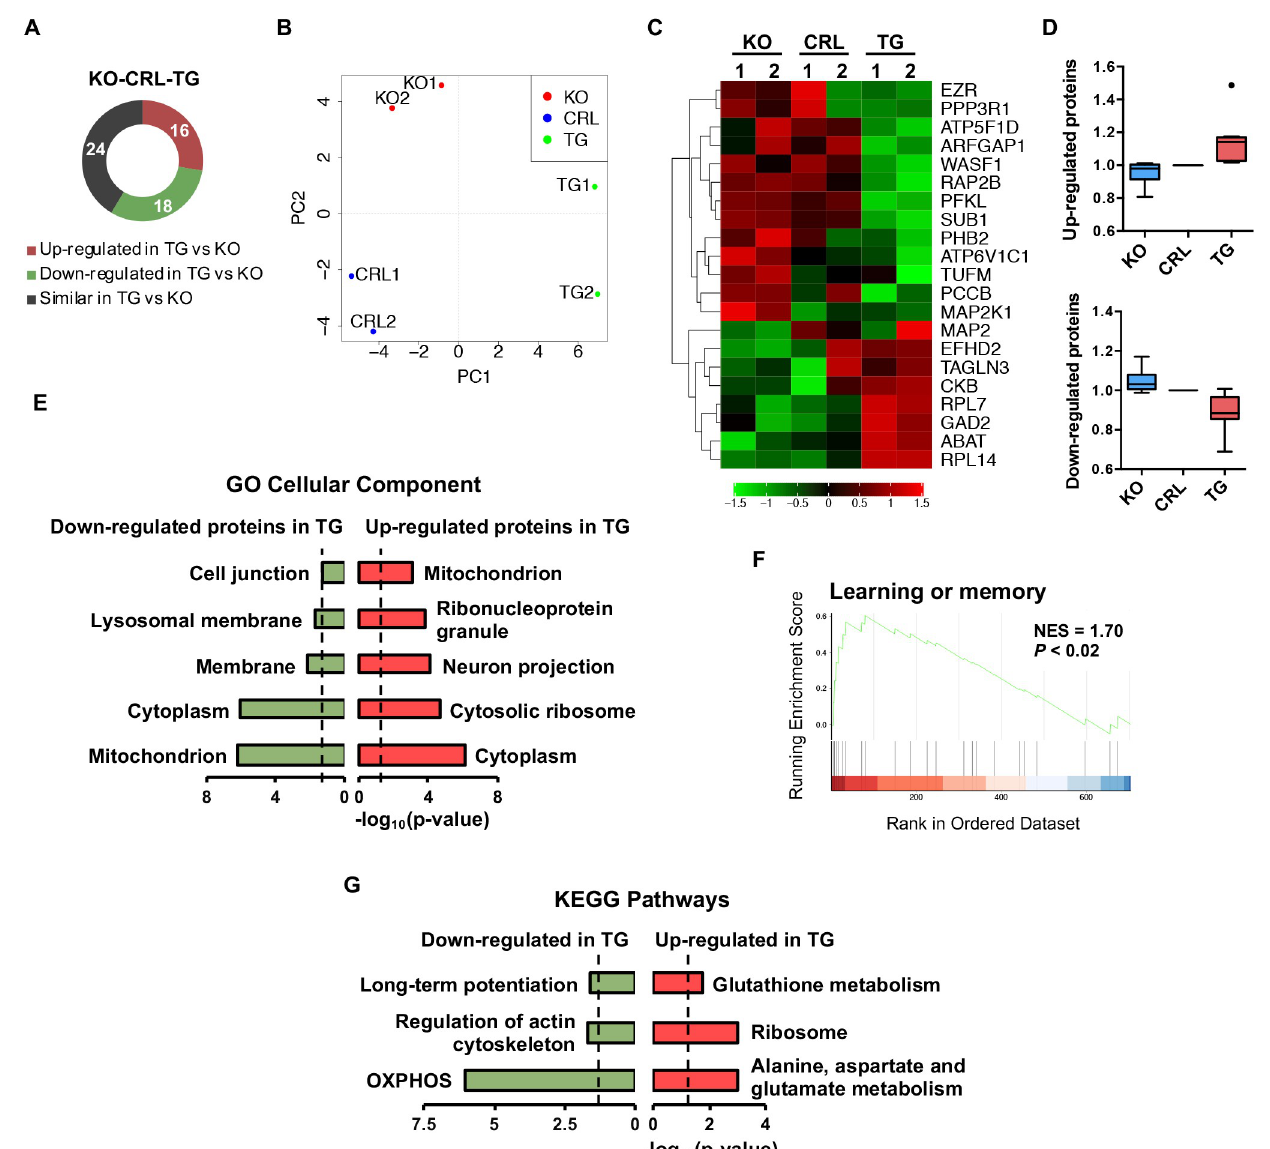
Fig 4. IF1 dose affects the proteome of hippocampal neurons. (A) Differentially expressed proteins among IF1 KO , CRL, and IF1 TG mice resulting from the iTRAQ analysis. (B) PCA of the 3 genotypes. (C) Heatmap depicting the proteins whose expression correlates with IF1 dose. (D) Box plots showing the expression of the proteins that increase or decrease with higher IF1 dose, expressed as fold of CRL ( n = 8 up-regulated and n = 13 down-regulated proteins; center line, median; box limits, upper and lower quartiles; whiskers, 1.5 × interquartile range; points, outlier). (E) Gene enrichment analysis of the down- and up-regulated proteins in IF1 TG with respect to IF1 KO mice, showing the significant GO cellular c. (F) Enrichment plot of a top hit obtained in GSEA from proteomic data. (G) Gene enrichment analysis of the down- and up-regulated proteins in IF1 TG vs. IF1 KO mice, showing the KEGG pathways significantly enriched. Numerical data underlying plots can be found in S1 Data. CRL, control; GSEA, gene set enrichment analysis; IF1, ATPase inhibitory factor 1; IF1 KO , IF1 knockout; IF1 TG , IF1 overexpressing transgenic; KEGG, Kyoto Encyclopedia of Genes and Genomes; KO, knockout; OXPHOS, oxidative phosphorylation; PCA, principal component